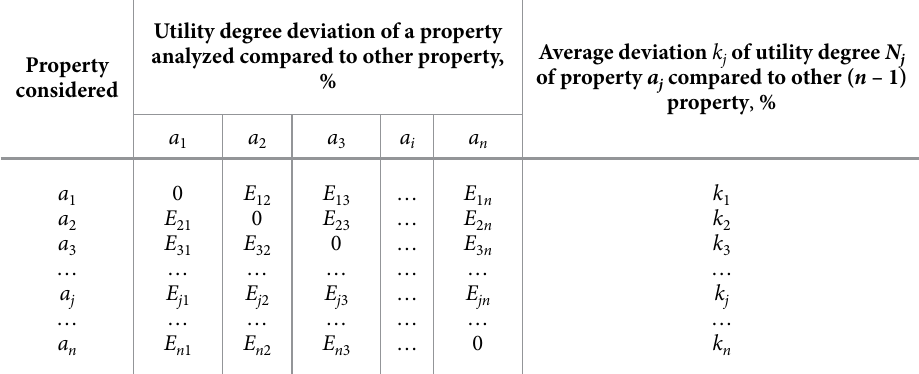
table 2. Calculation of average deviations of the property utility degrees utility degree deviation of a property analyzed compared to other property, property considered